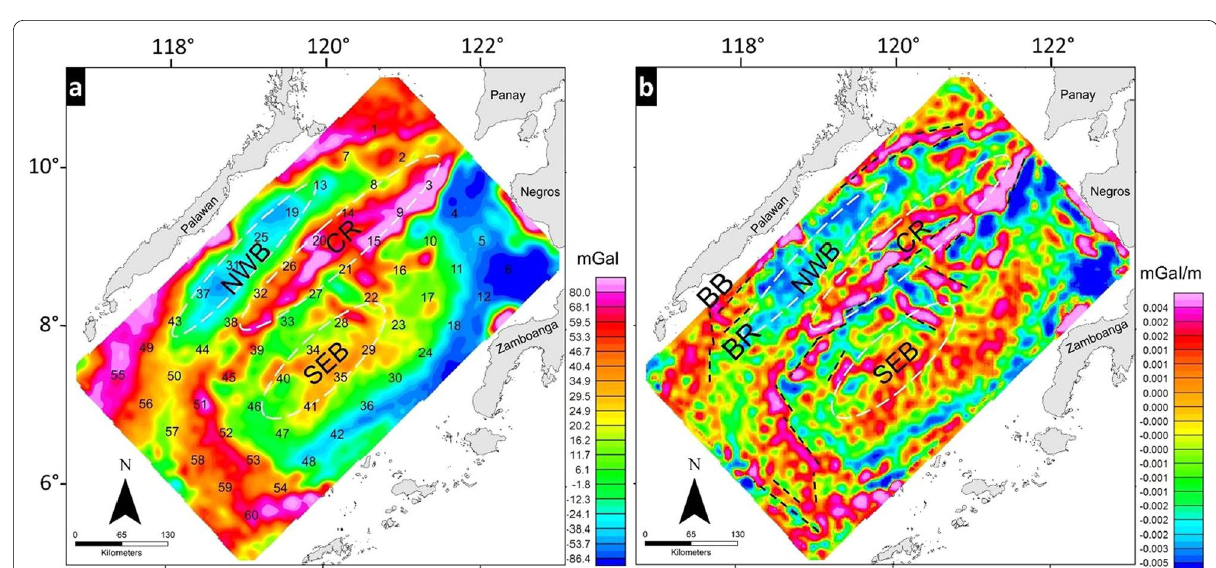
Fig. 7 a FAA map of Sulu Sea showing the three major features: NWB represent the center of the sub-windows location for the calculation of the radially averaged power spectrum. b The first vertical derivative map reveals the Sulu Sea’s enhanced shallow features. Prominent lineaments were traced (black dashed line) corresponding to some large-scale structures (e.g., Rangin 1989; Schlüter et al. 1996). BB